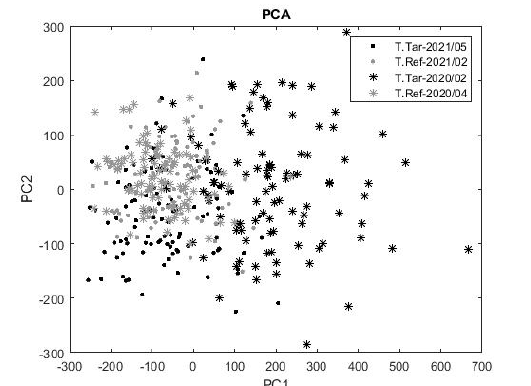
Figure 9. Plot of the PCA first and second principal components: as along the X axis of the plot the points of the faulty dataset appear separated from the healthy ones, PC1 was considered a valuable parameter for the detection of damage.